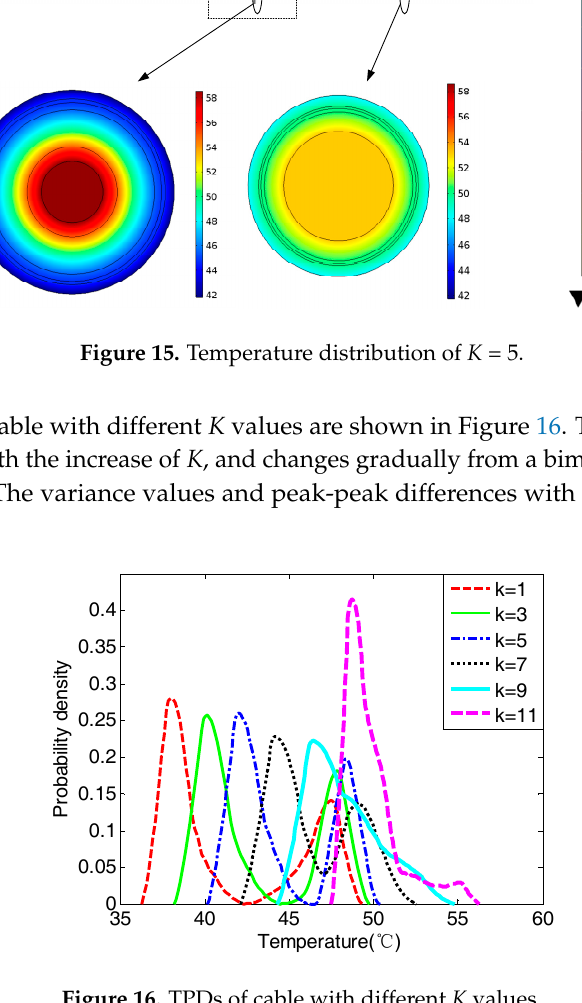
Figure 16. TPDs of cable with different K values. Table 8. Characteristics of TPDs under different K values.